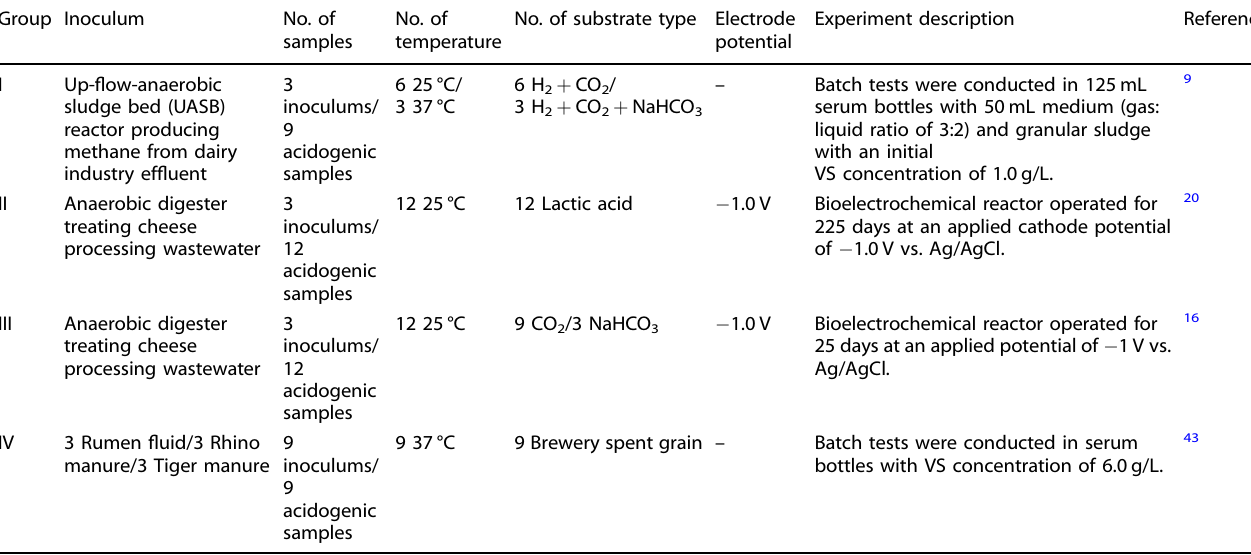
Table 2. Details of the 60 samples collected from the four